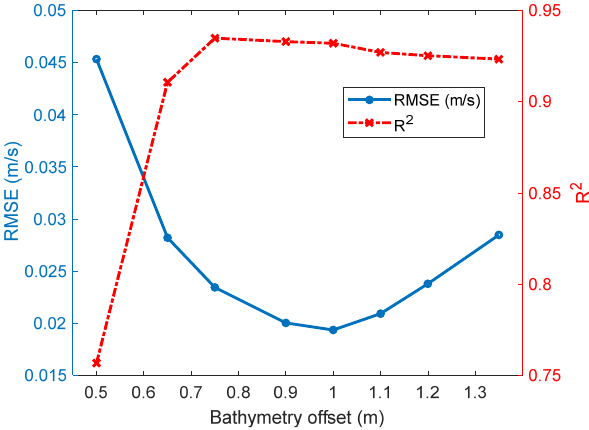
Figure 5. Root-mean-square error (RMSE) and R 2 variations against variation in bathymetry values Figure 5. Root ‐ mean ‐ square error (RMSE) and R 2 variations against variation in bathymetry values show the optimum bathymetry o ff show the optimum bathymetry offset.